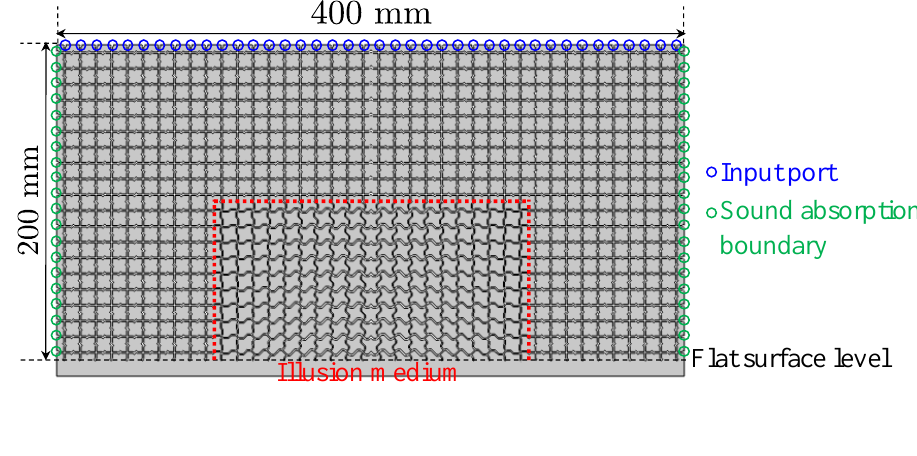
Figure 13. Complex sound pressure distributions for the acoustic carpet cloak, the flat surface, and 230 the bump. ( a ) 1.0 kHz ( λ /∆ d = 22.3); ( b ) 1.5 kHz ( λ /∆ d = 14.8); ( c ) 2.0 kHz ( λ /∆ d = 11.1); ( d ) 2.5 kHz 231 ( λ /∆ d = 8.91); ( e ) 3.0 kHz ( λ /∆ d = 7.42); ( f ) 3.5 kHz ( λ /∆ d = 6.36). Left: Amplitude. Right: Phase. 232